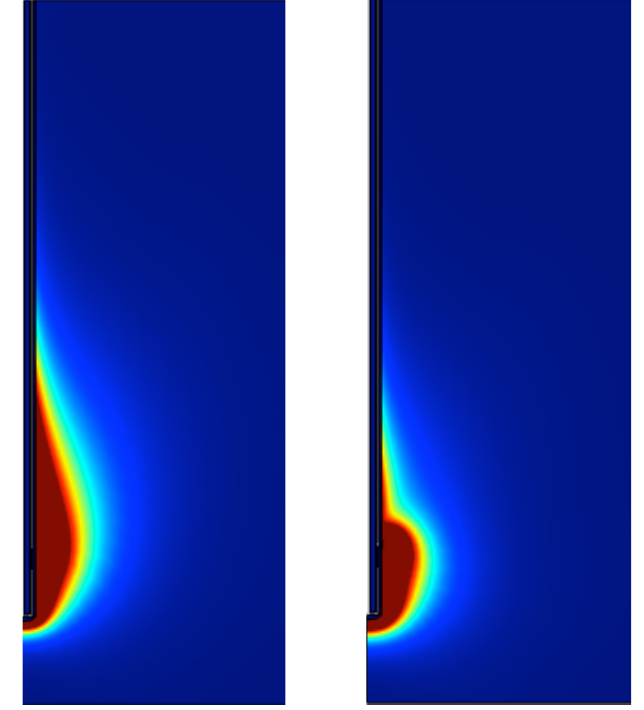
Figure 6: Microwave power absorbed in the liver for a) classical MCA b) new MCA with 1T-ring shape